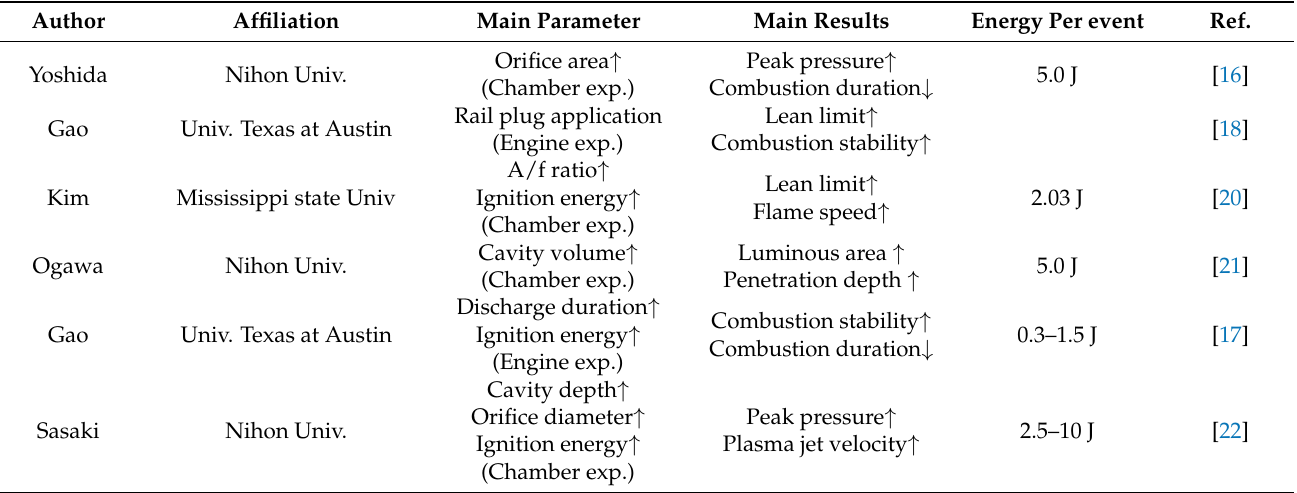
Table 1. Summary of plasma jet ignition studies.